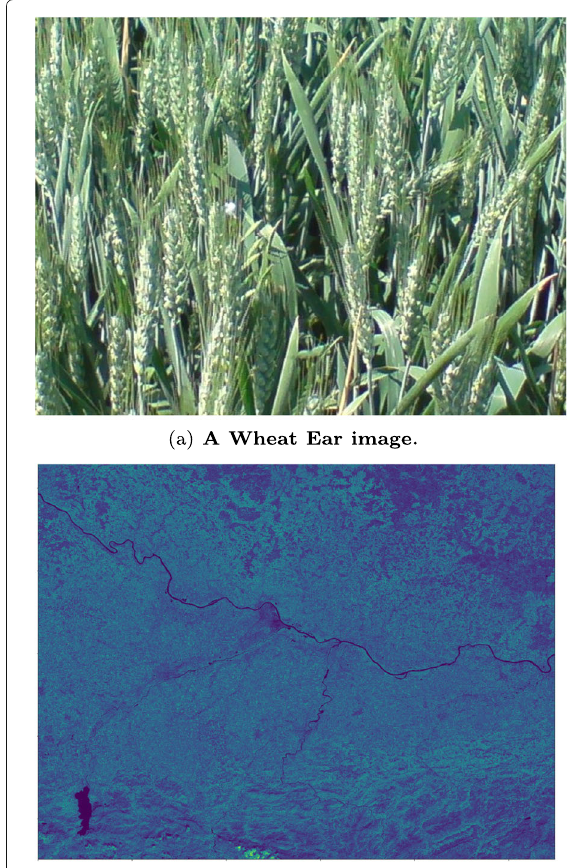
Fig. 10 Examples of Pilot images. The Sentinel-2 image deliver information of three key stages of soya growth